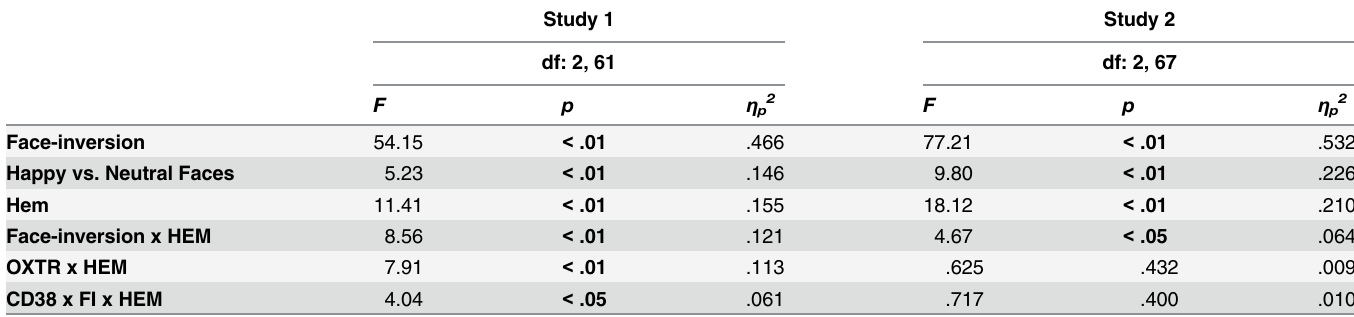
Table 6. Results of ANOVAs with repeated measurements regarding N170-amplitudes in reaction to upright and inverted happy, and neutral faces; Hemisphere (HEM), perspective (upright vs. inverted picture), CD38-SNP rs379863 (CD38), Oxytocin-receptor-gene-polymorphism rs53576 (OXTR).